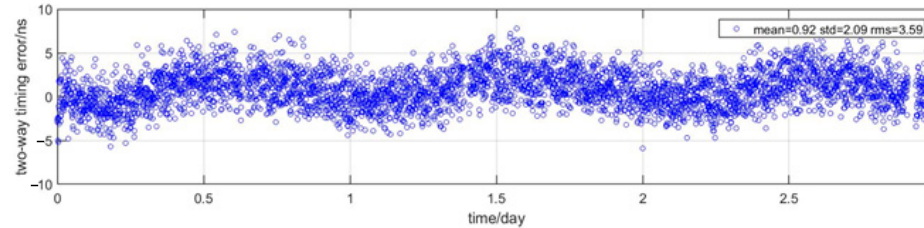
Figure 7. RDSS two-way timing error (normal state) .